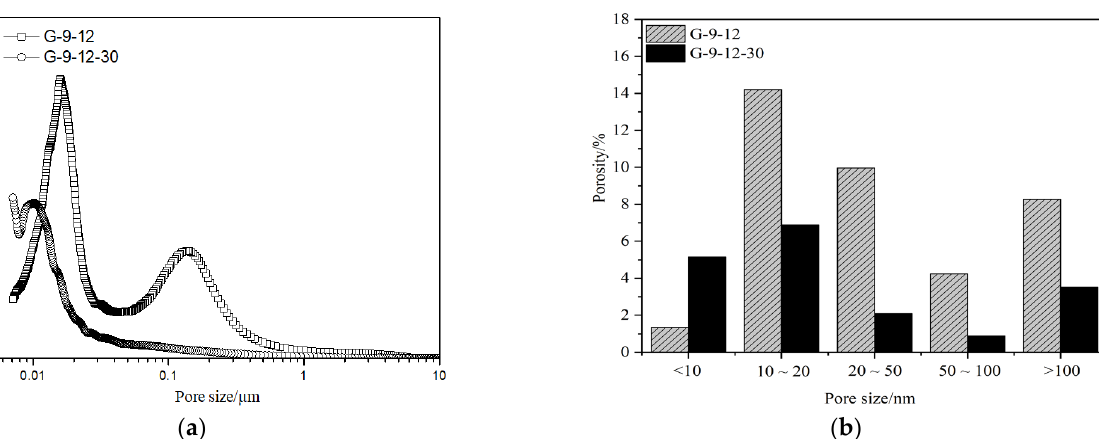
Figure 6. Pore size distribution of FA-based geopolymer grouting materials: ( a ) differential curves of pore size distribution; ( b ) proportion of pores.